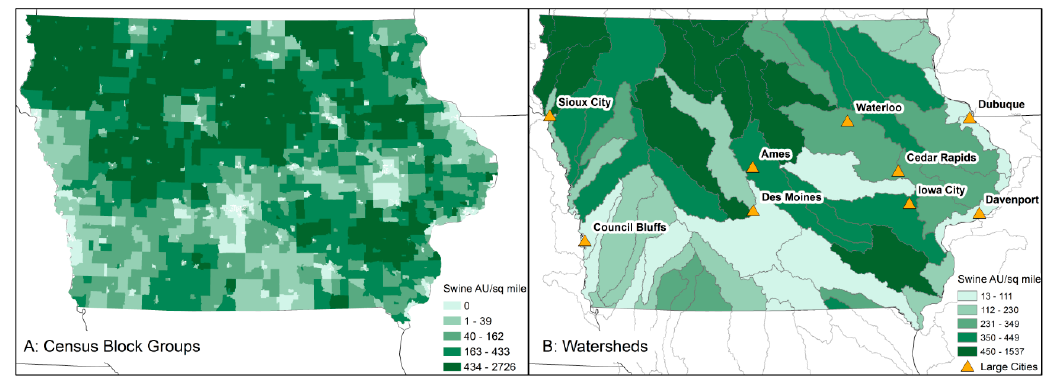
Figure 3. Swine AU density by CBG ( A ) and watershed ( B ) in Iowa. Larger cities (>50,000 people) are represented in ( B ).